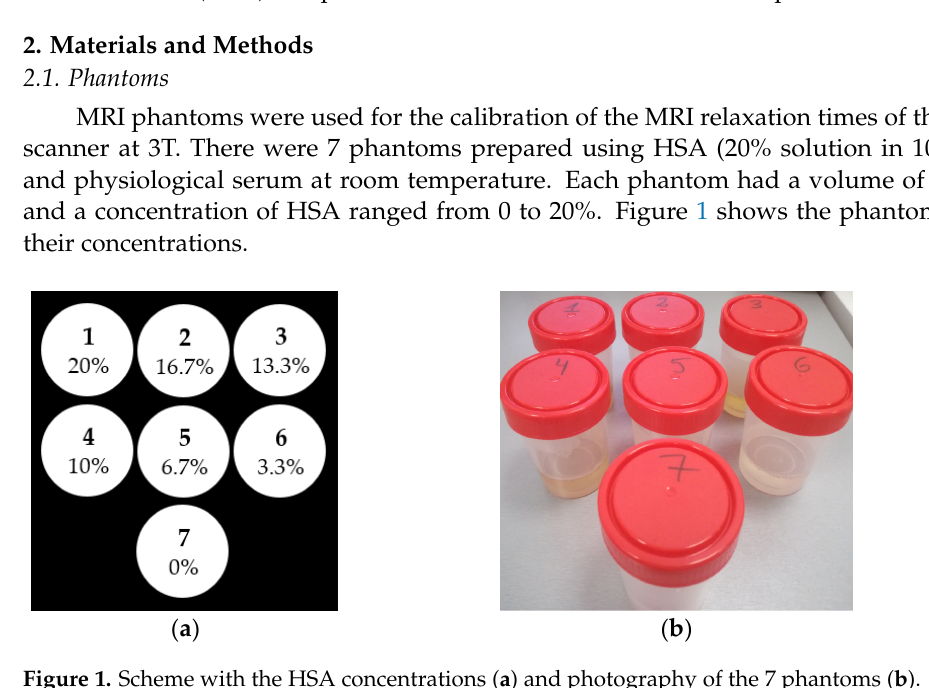
Figure 1. Scheme with the HSA concentrations ( a ) and photography of the 7 phantoms ( b ). One of the reasons for selecting the HSA protein is because the MRI relaxation time of this protein is similar to the MRI relaxation times of the human tissue [21].